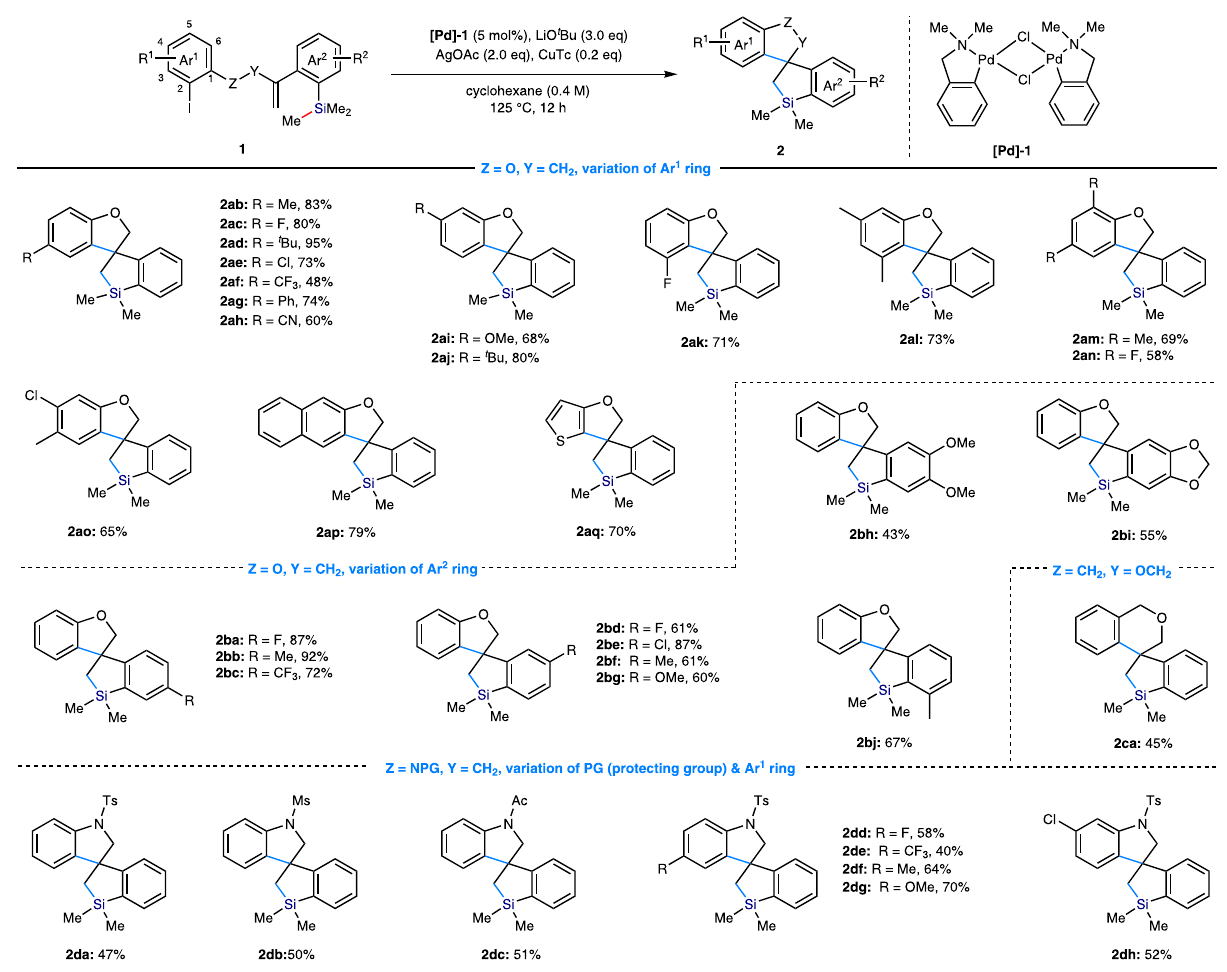
Fig. 2 | Substrate scopefor the Pd-catalyzedsila-spirocyclization of1 involving Si – C(sp3) bond cleavage/coupling. Reactions were carried out by using [Pd]-1 (0.01mmol), LiO t Bu (0.6mmol), AgOAc (0.4mmol), CuTc (0.04 – 0.2mmol), and 1